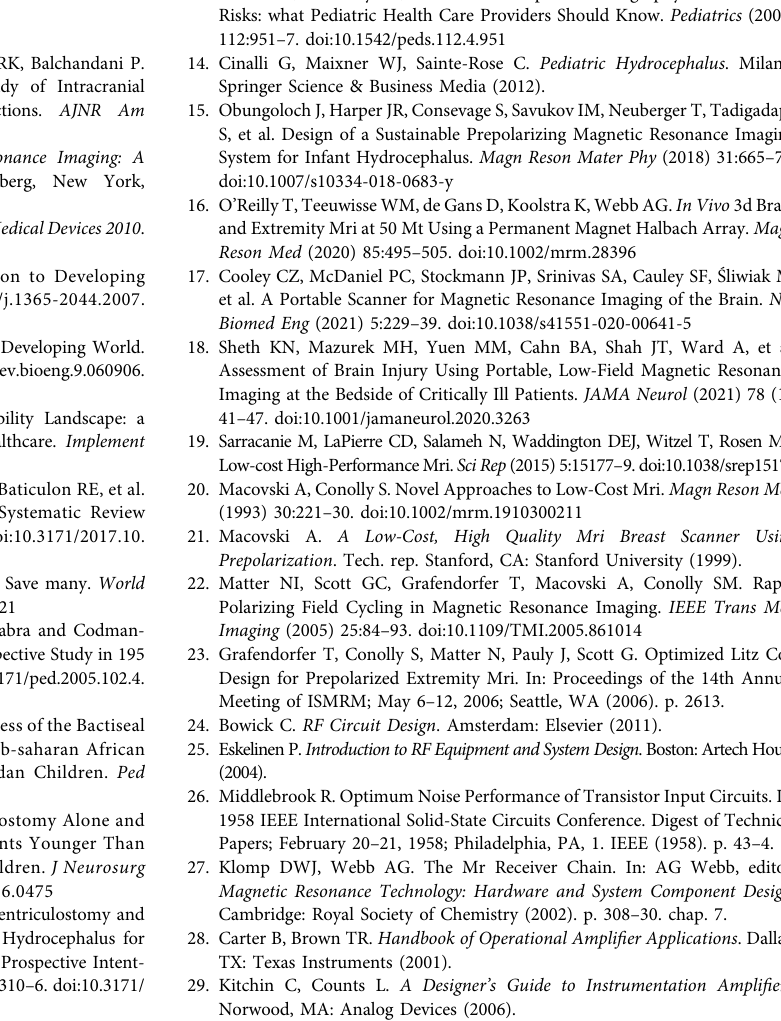
Supplementary Figure S1 | The circuit diagram for the Transmit ampli fi